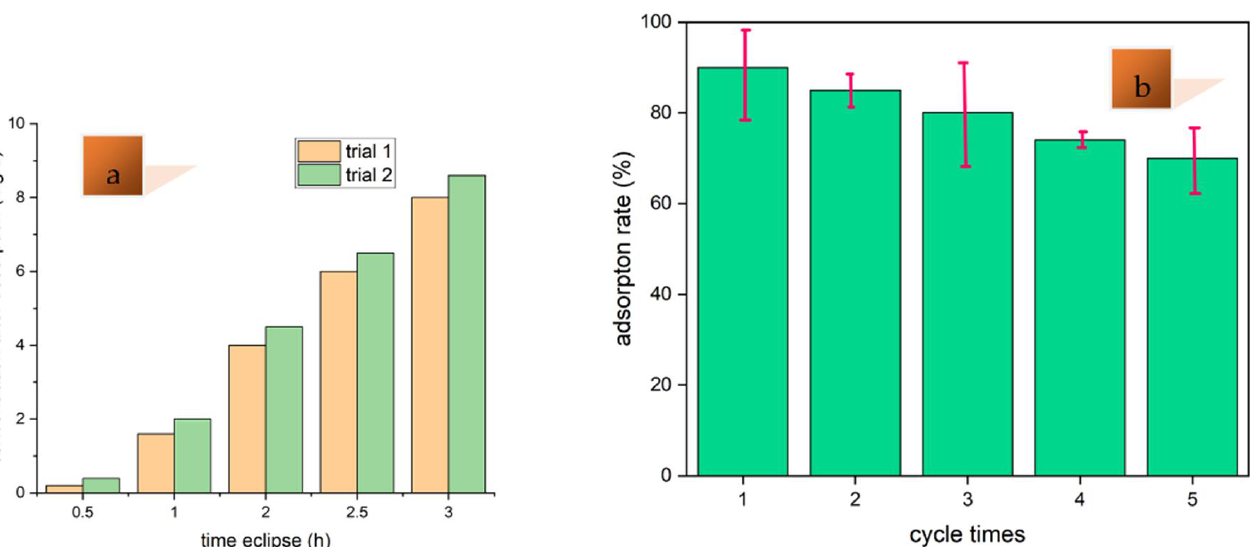
Figure 6. Several sewage analysis parameters showed a reduction in the concentration of major pol- lutants by sponge – La.